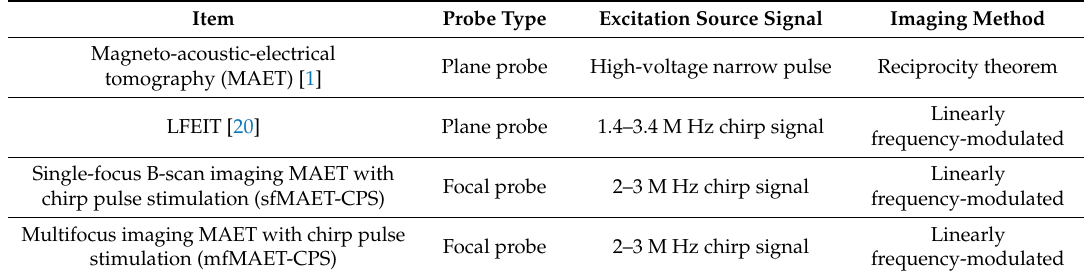
Table 1. Technical comparisons between our proposed system and other similar